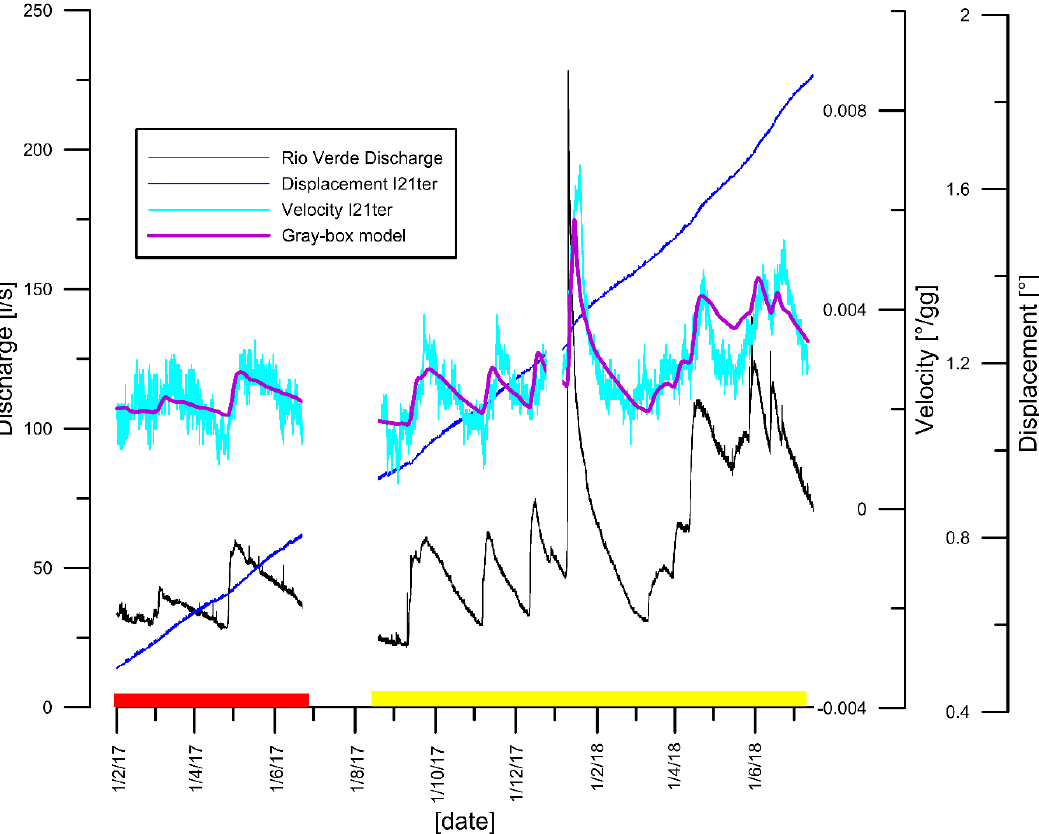
Figure 5. Discharge in the Rio Verde and velocities recorded in I21ter. The fitting of Equation (1) is shown in purple; the yellow period was used for calibration, and the red one is the validation dataset.